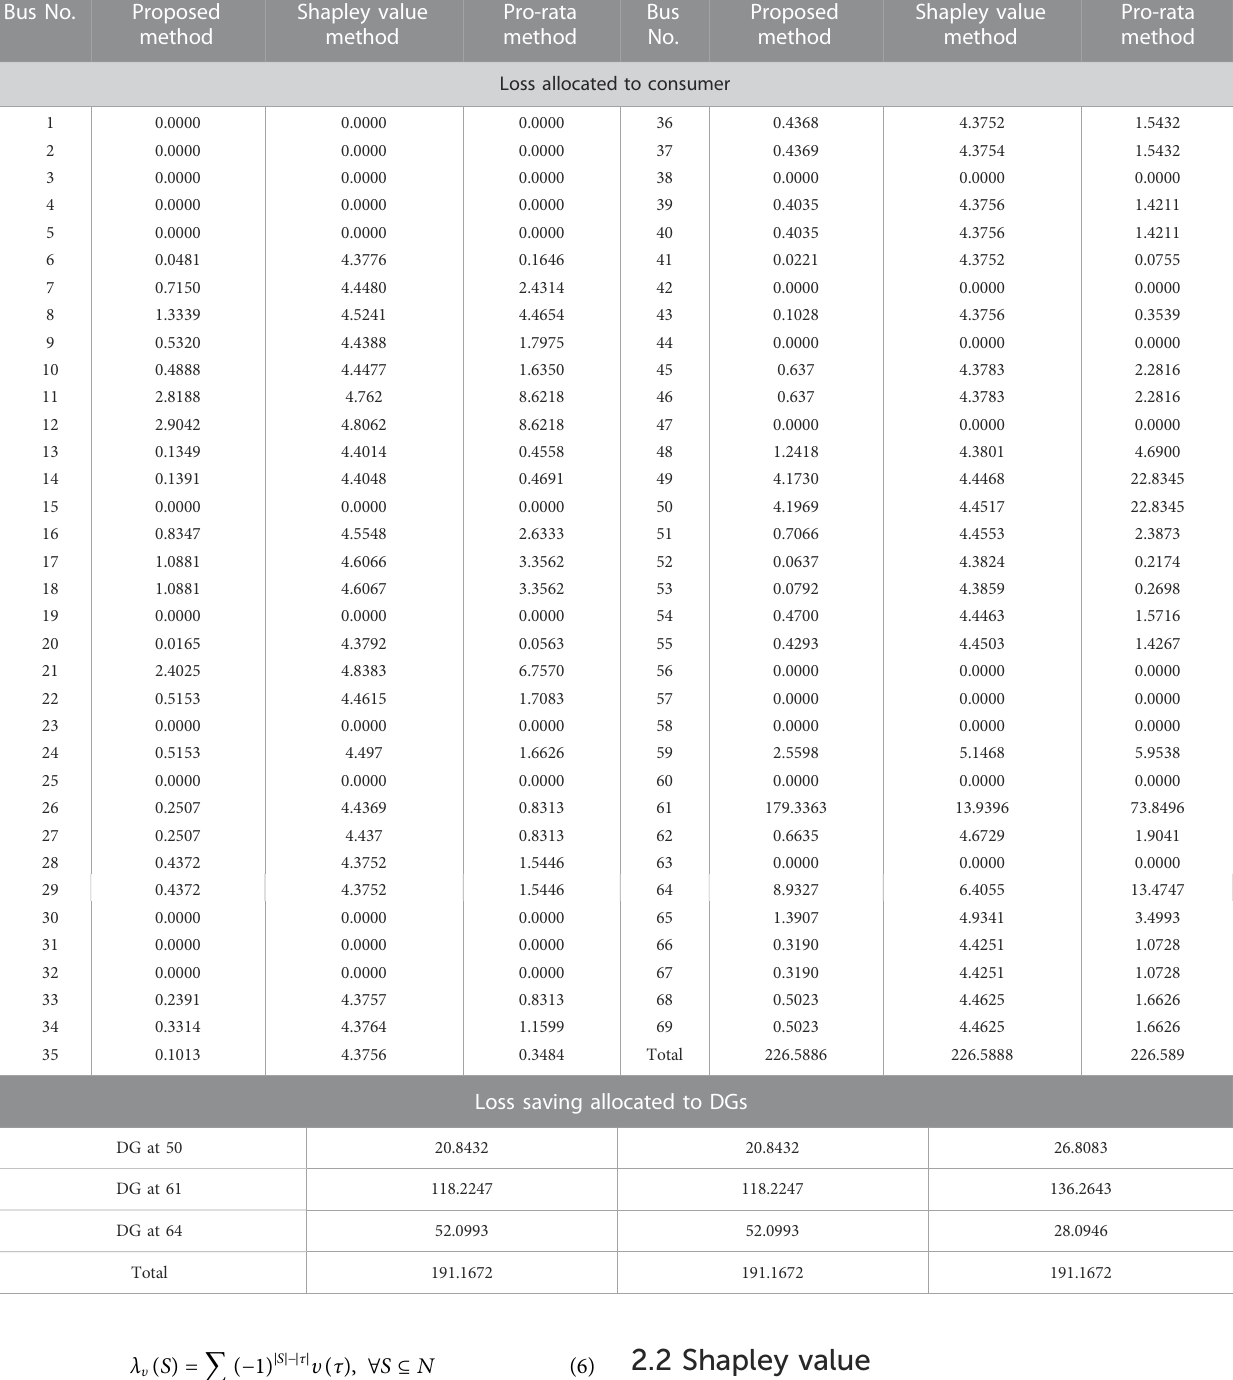
TABLE 4 Comparison of allocated losses (in kW) and loss saving (in kW) to load and DG, respectively, of 69-bus DS by all three given methods. Bus